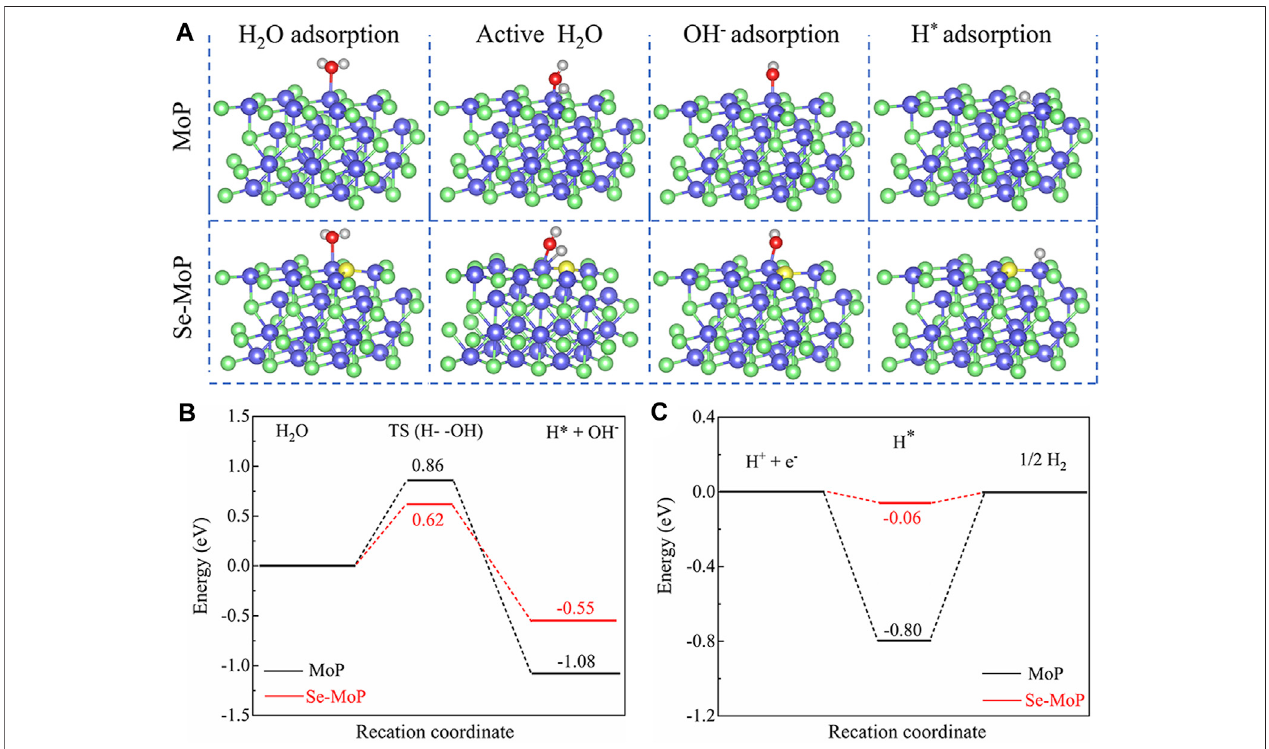
FIGURE 4 | DFT calculations of pure MoP and Se doped MoP. (A) Calculation models of the surface, H 2 O adsorption, OH − adsorption and H* adsorption of MoP and Se-MoP. The blue, green, yellow, red, and gray spheres represent Mo, P, Se, O, and H atoms, respectively. (B) The calculated activation energy barriers of H 2 O molecules and (C) adsorption energies of H* on MoP (black) and Se-MoP surfaces